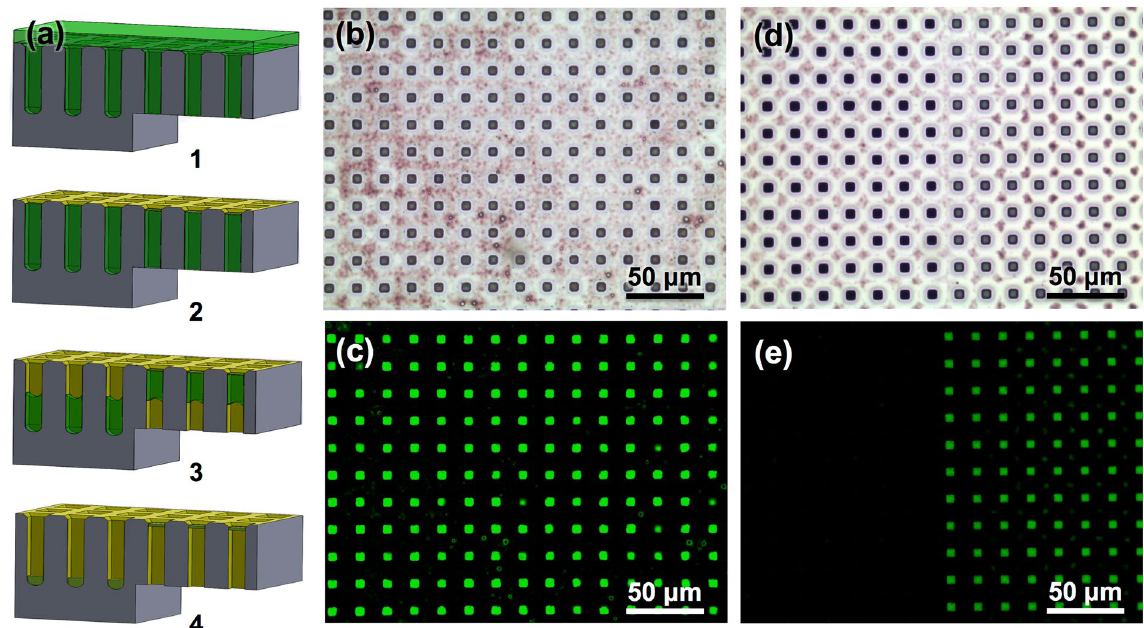
Figure 2. Preparation of Micrometric Suspended F8BT Membrane Lattices on Open-Ended Pass-Through Micropipes. ( a ) Sketch showing the phases of membrane formation in silicon microstructured templates featuring both closed-ended and open-ended pass-through micropipes leading to suspended membrane formation only on these latter (positive control samples): (a-1) polymer infiltration pattern resulting from drop- casting deposition of 10 μ L of polymer solution with 1 wt% of F8BT onto silicon microstructured templates featuring a 2D array of both closed-ended and open-ended pass-through micropipes, also highlighting the stop- valve mechanism taking place in open-ended pass-through micropipes and the complete filling of closed-ended micropipes, (a-2) formation of a continuous polymer layer on top of the silicon microstructured template upon solvent evaporation from the solution on top of the template, (a-3) solvent evaporation causing flow menisci either to move downward in closed-ended micropipes or to move backward in open-ended pass-through micropipes, (a-4) suspended polymer membrane formation at the inlet of open-ended pass-through micropipes and thick polymer layer deposited at the bottom of closed-ended micropipes upon full solvent evaporation. ( b – e ) Bright-field ( b , d ) and fluorescence ( c , e ) optical top view images acquired in the area with open-ended pass-through micropipes (b,c) and at the boundary between open-ended pass-through micropipes (right) and closed-ended micropipes (left) (d,e) showing suspended F8BT membranes formed at the inlet of open-ended pass-through micropipes after drop-casting deposition of 10 μ L of polymer solution with 1 wt% of F8BT onto a silicon template as sketched in ( a